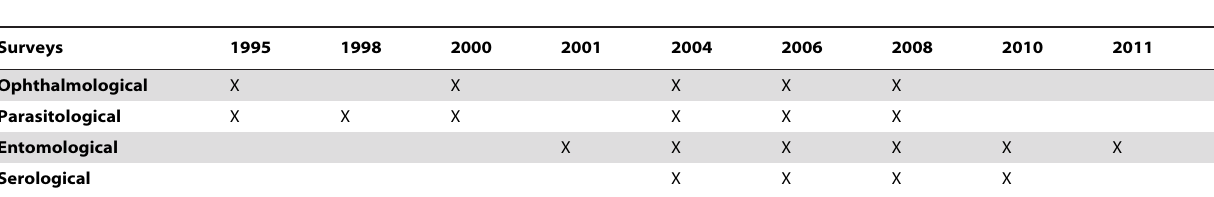
Table 1. In-depth epidemiologic assessments in sentinel and extra-sentinel communities of the Southern Chiapas focus.